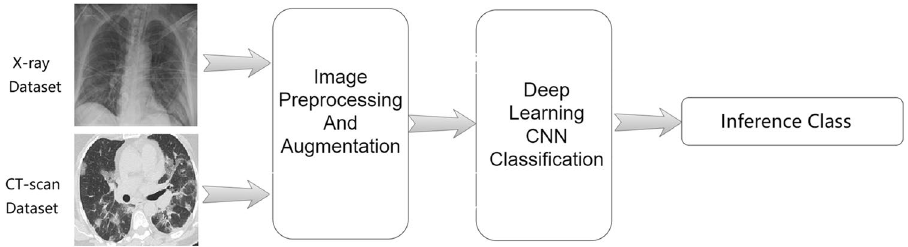
Figure 1. Deep learning based screening structure of